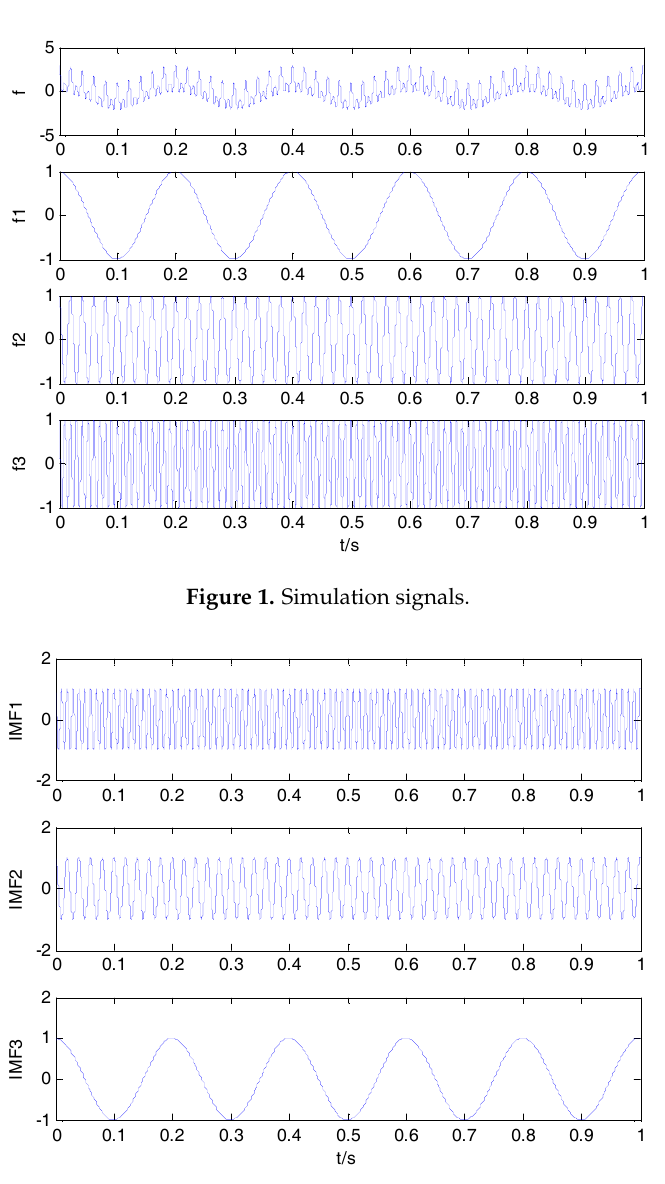
Figure 2. Decomposition result by variational mode decomposition (VMD). Table 2. The CCs between simulation signal and corresponding intrinsic mode functions (IMFs).